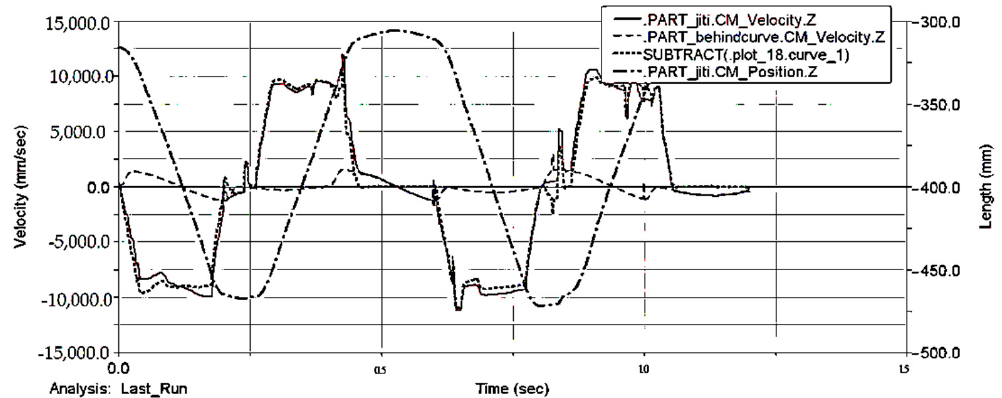
Figure 16. The bolt body motion of clearance and recoil.